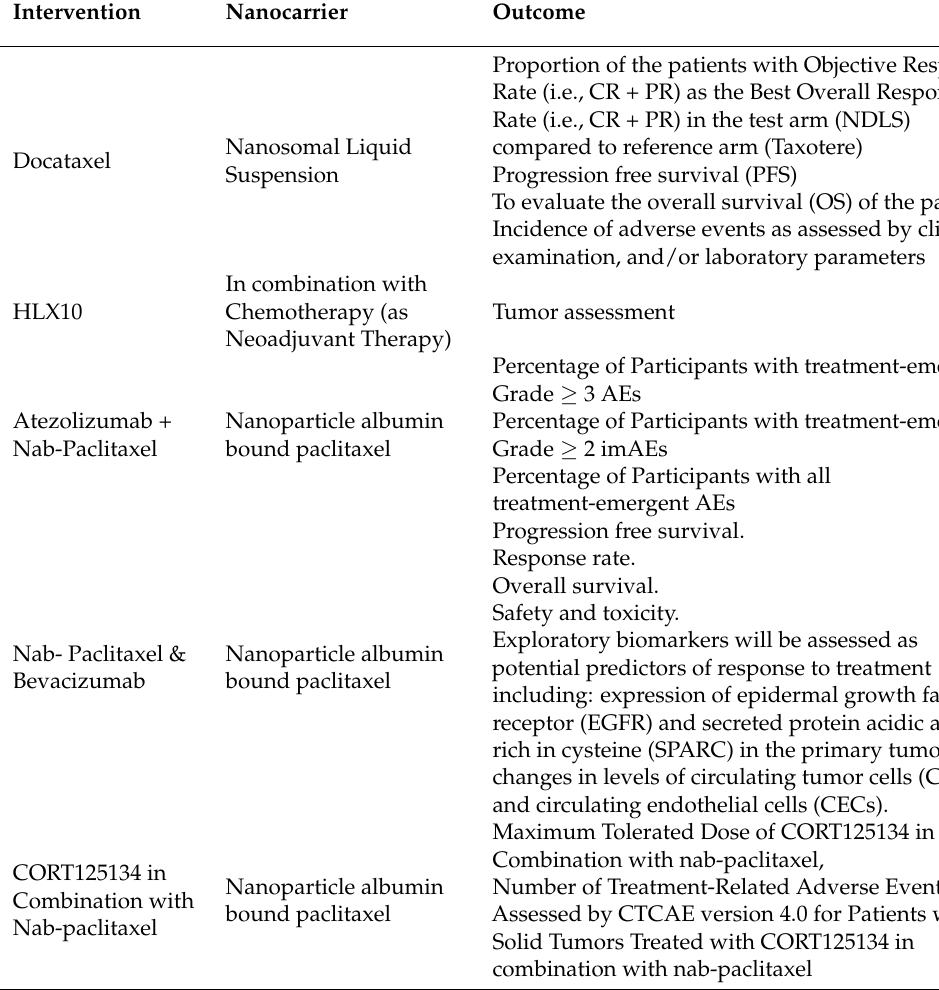
Table 2. Key Clinical trials and their outcomes which aimed to explore the nanotechnology-based approaches against TNBC.